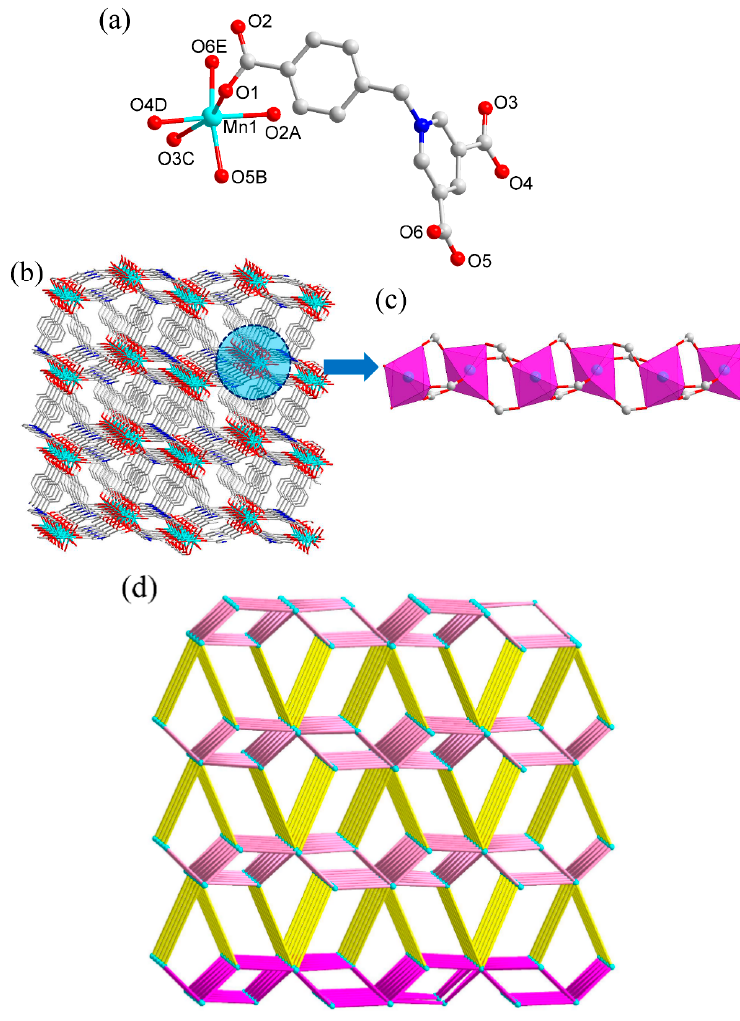
Figure 2. ( a ) Coordination environment of the metal atom and ligand of 2 (symmetry codes: (A)